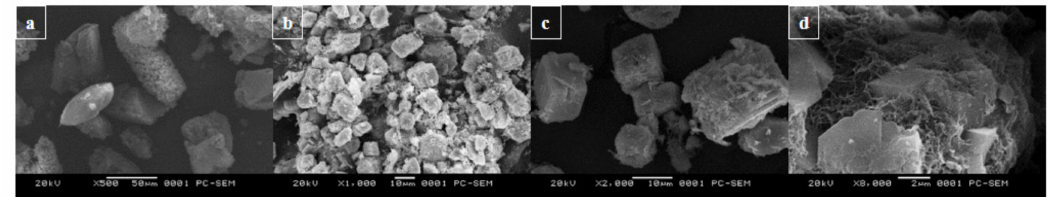
Figure 6. SEM micro morphology of crystal (( a ): 500 times; ( b ): 1000 times; ( c ): 2000 times; ( d ): 8000